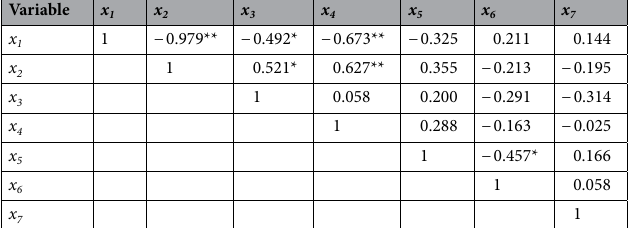
Table 2. Correlation coefficients between independent variables. The sign ‘*’ or ‘**’ indicates that the correlation is significant at 0.05 level or 0.01 level.